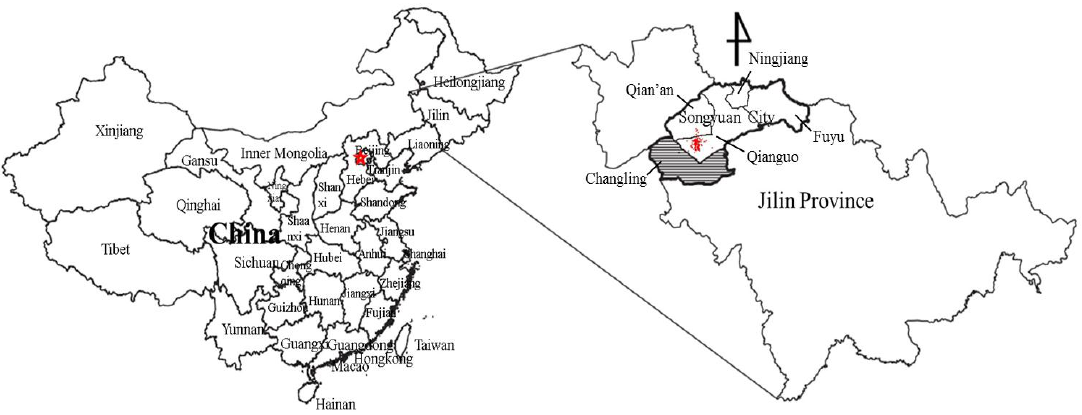
Figure 2. Location of study area. The red spot in Jilin Province indicates the epicenters of the earthquake swarm. The shaded part is the survey area.